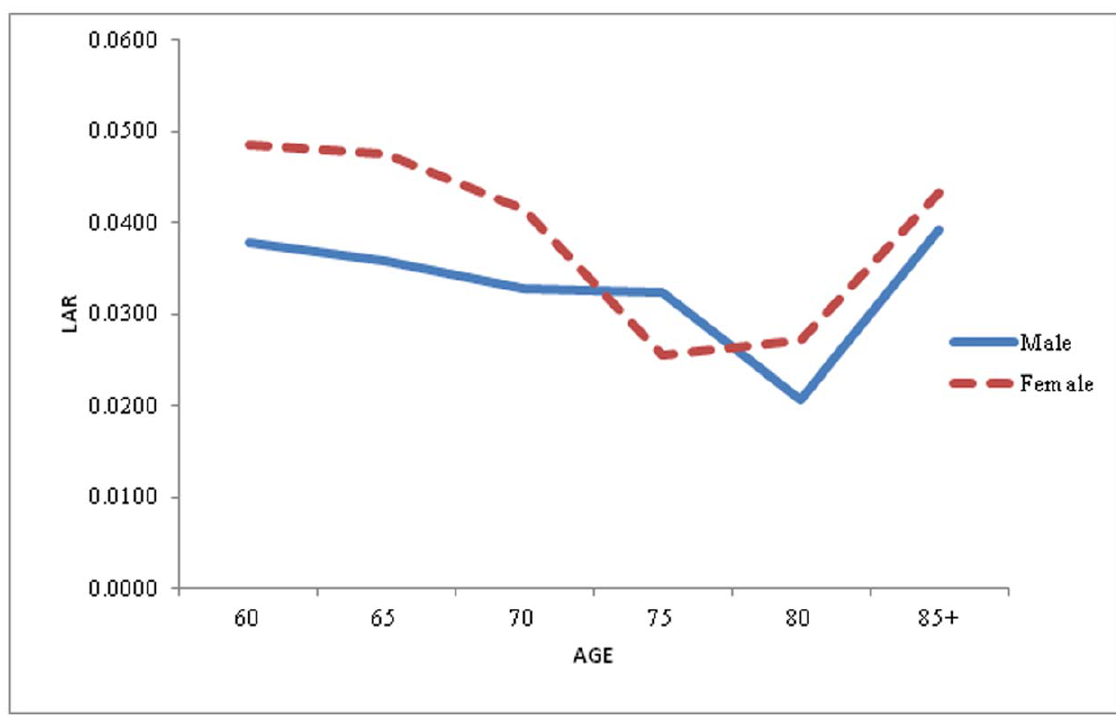
Figure 3. Life Table Aging Rate (LAR) for Male and Female in the older age, India, 1999.